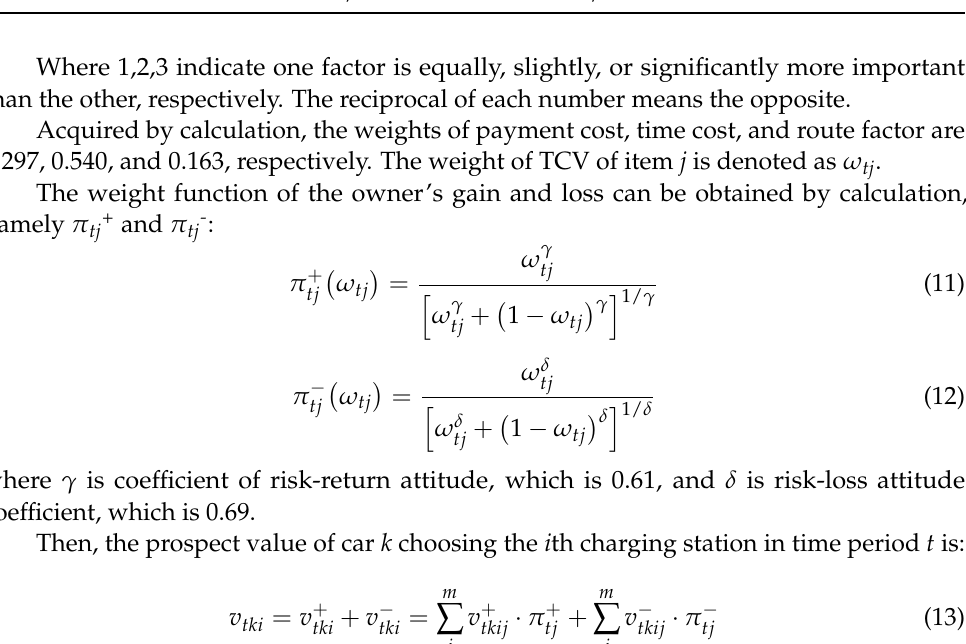
Table 2. Comparison of importance decided by AHP. Array Payment Time Cost Route Payment 1 1/2 2 Time Cost 2 1 3 Route 1/2 1/3